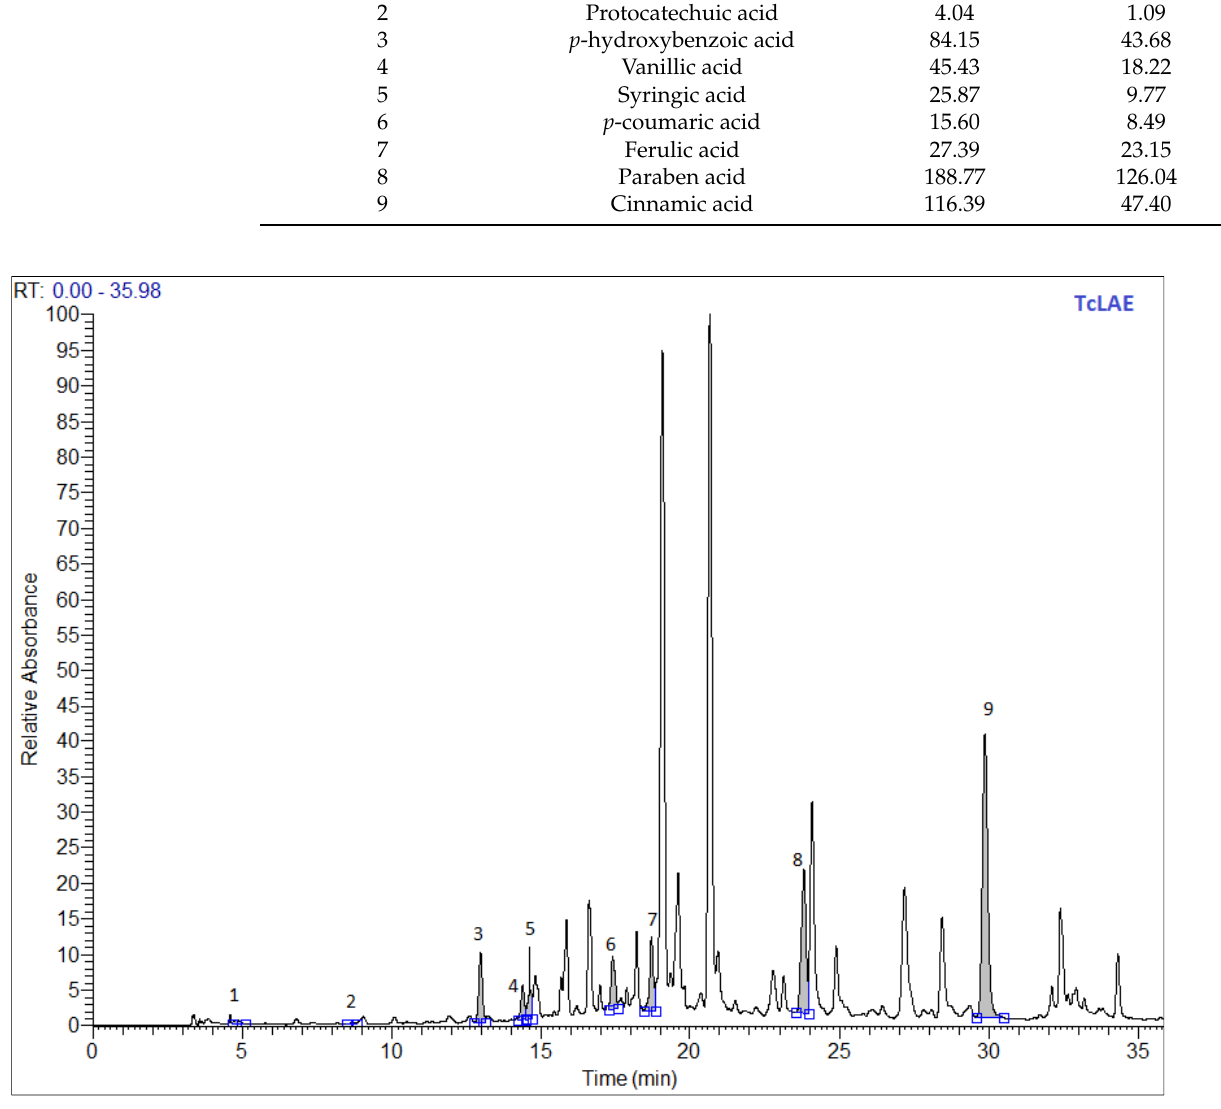
Figure 2. LC–MS chromatogram of phenolic compounds in the acetonic extracts of Thymus capitatus , as leaves detected at 280 nm.